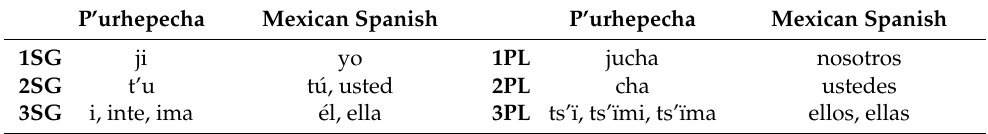
Table 2. Subject pronoun paradigms in P’urhepecha and Mexican Spanish.